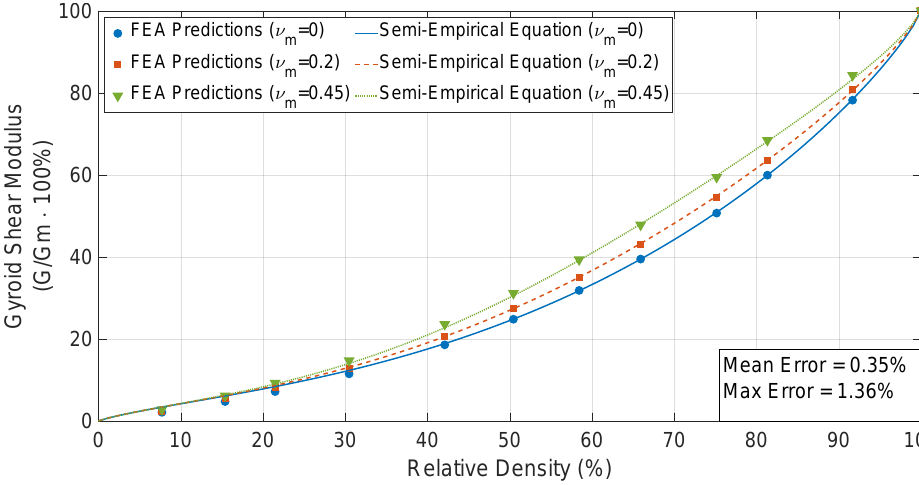
Figure 14. FEA predictions vs. semi-empirical equation for shear